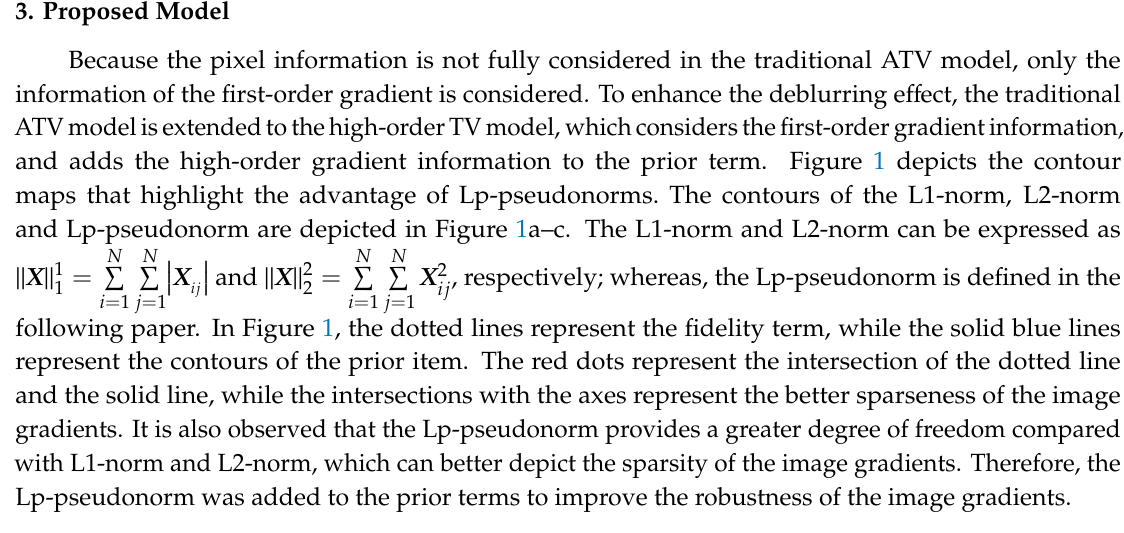
following paper. In Figure 1, the dotted lines represent the fidelity term, while the solid blue lines represent the contours of the prior item. The red dots represent the intersection of the dotted line and the solid line, while the intersections with the axes represent the better sparseness of the image gradients. It is also observed that the Lp-pseudonorm provides a greater degree of freedom compared with L1-norm and L2-norm, which can better depict the sparsity of the image gradients. Therefore, the Lp-pseudonorm was added to the prior terms to improve the robustness of the image